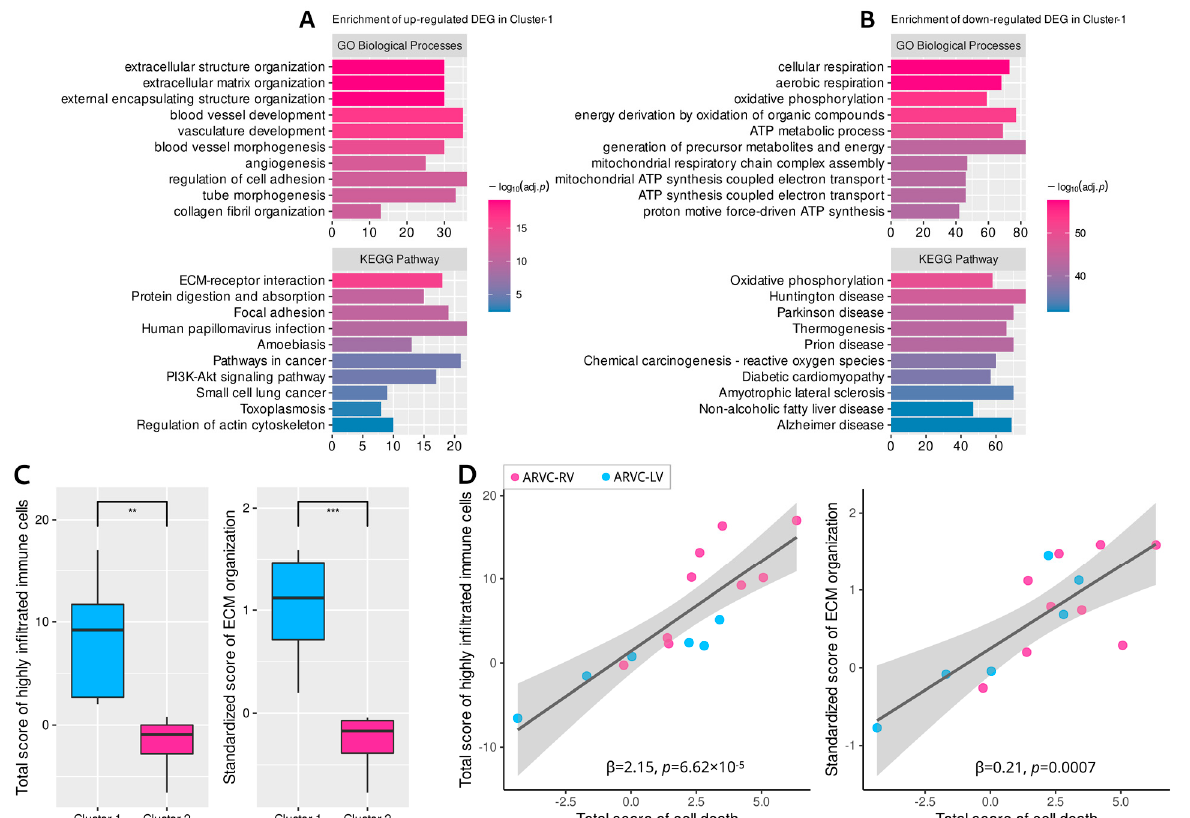
Figure 5. Enrichment analysis of the differentially expressed genes (DEGs) between the two clusters and functional correlation analysis. ( A ): Enrichment results of the up-regulated DEGs in cluster-1. ( B ): Enrichment results of the down-regulated DEGs in cluster-1. ( C ): Comparisons of the total scores of the highly infiltrated immune cells in ARVC and fibrosis activity (ECM organization) between the two clusters. ( D ): Positive linear correlations of cell death levels with immune cell infiltration and fibrosis. ECM, extracellular matrix. Other abbreviations are the same as in Figures 1 and 2. *** p < 0.001; ** p < 0.01.